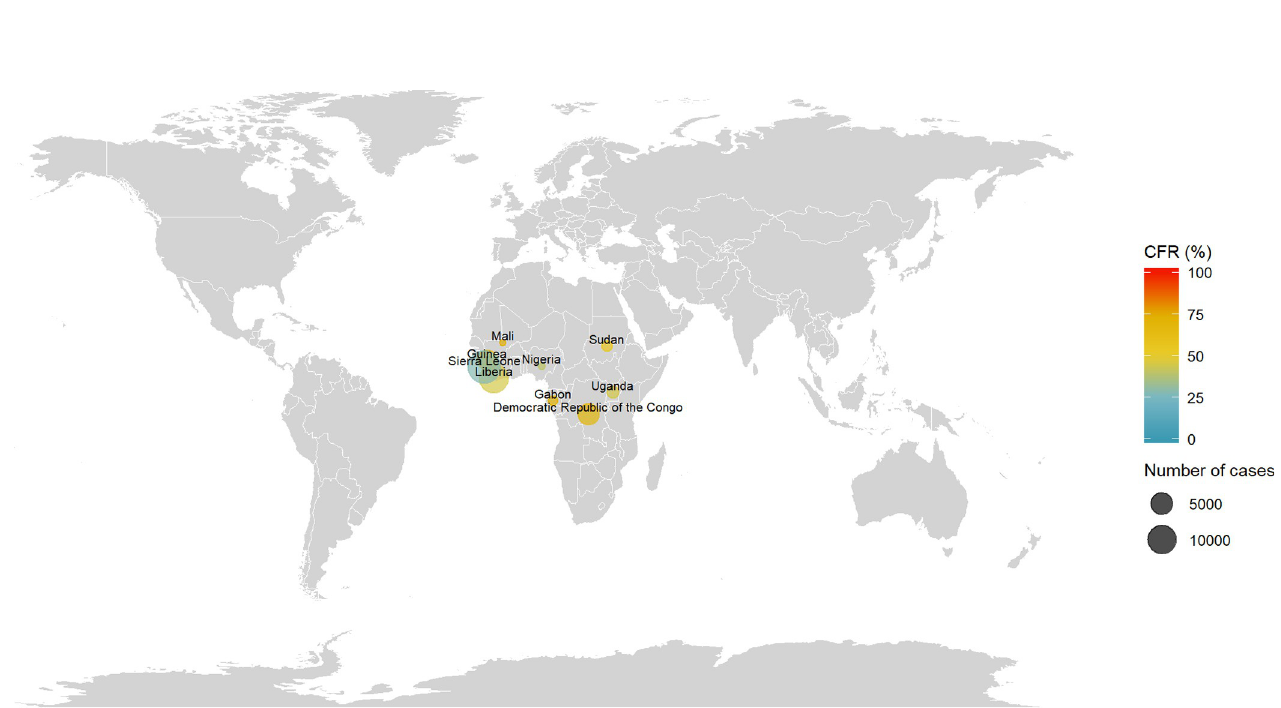
Fig 4. Distribution of number of cases and CFR of Ebola Virus Disease. The size of the bubble is proportional with the number of cases reported and the color denotes the level of CFR by country. Note: Maps were generated with the ‘maps’ R package using data from the Natural Earth Project (the 1:50m resolution